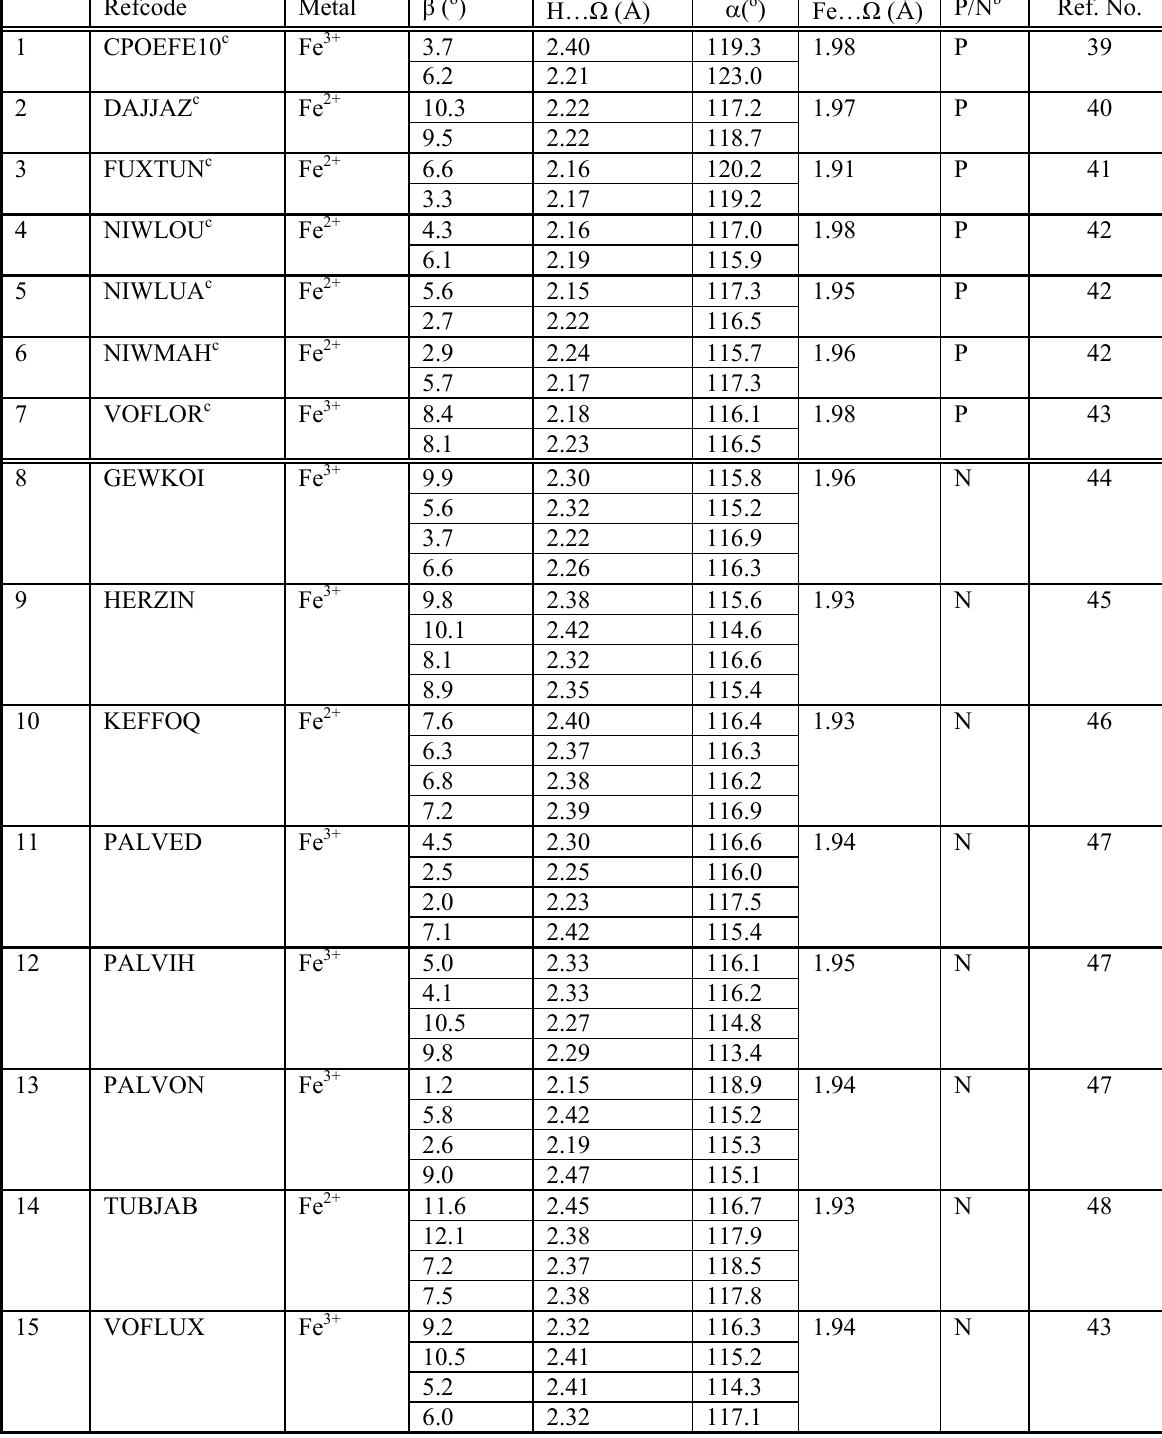
Table 2. Some of geometrical data a for intramolecular C − H ⋅⋅⋅π interaction in Fe complexes with porphyrin derivate and two axially coordinated